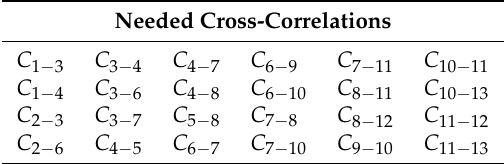
Table 2. Needed cross-correlations for the Figure 7